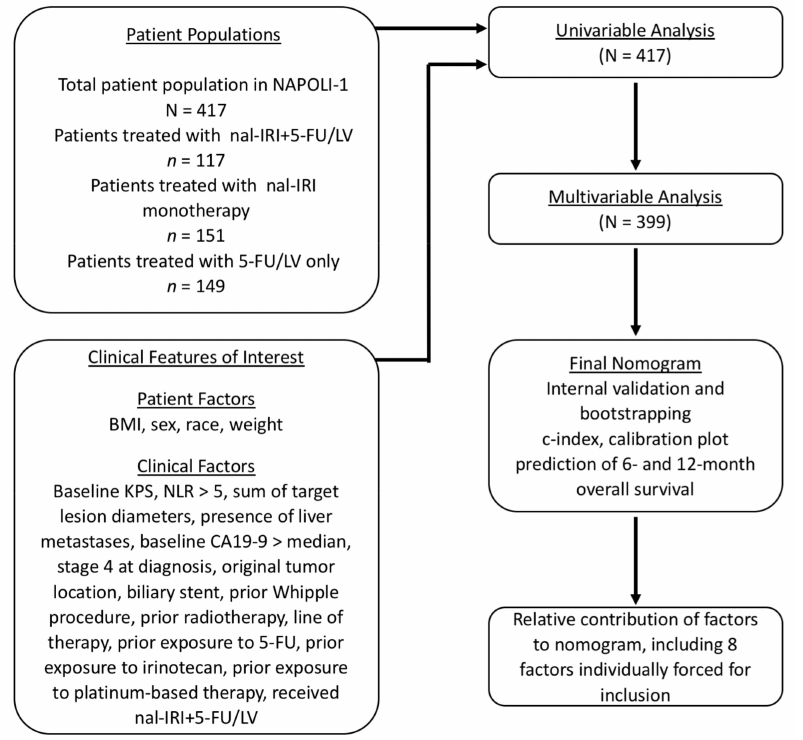
Figure 1. Statistical analysis